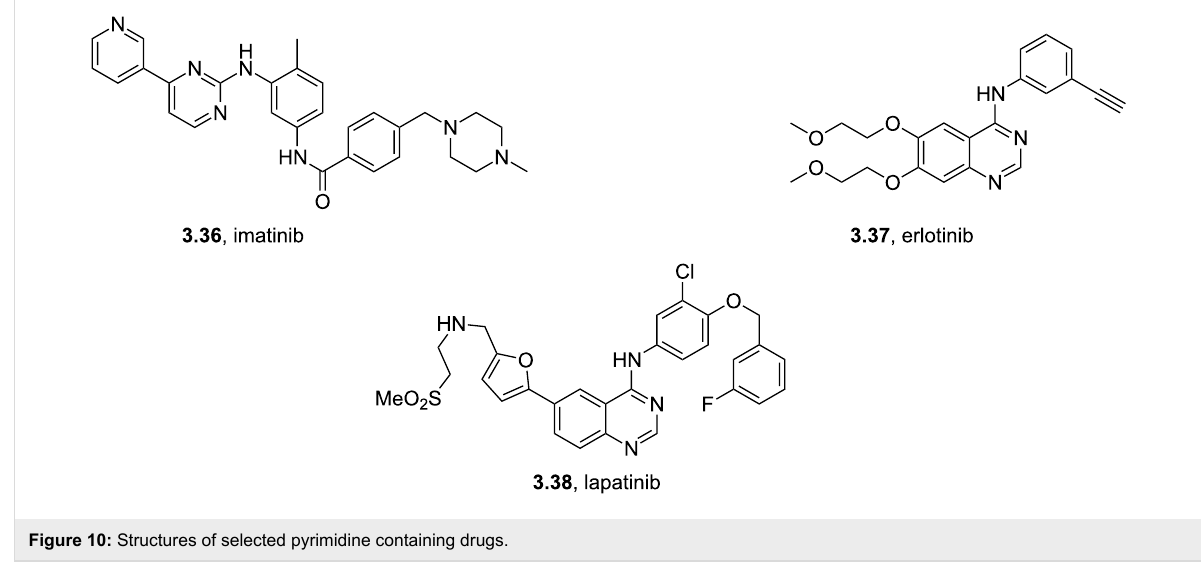
Figure 10: Structures of selected pyrimidine containing drugs.